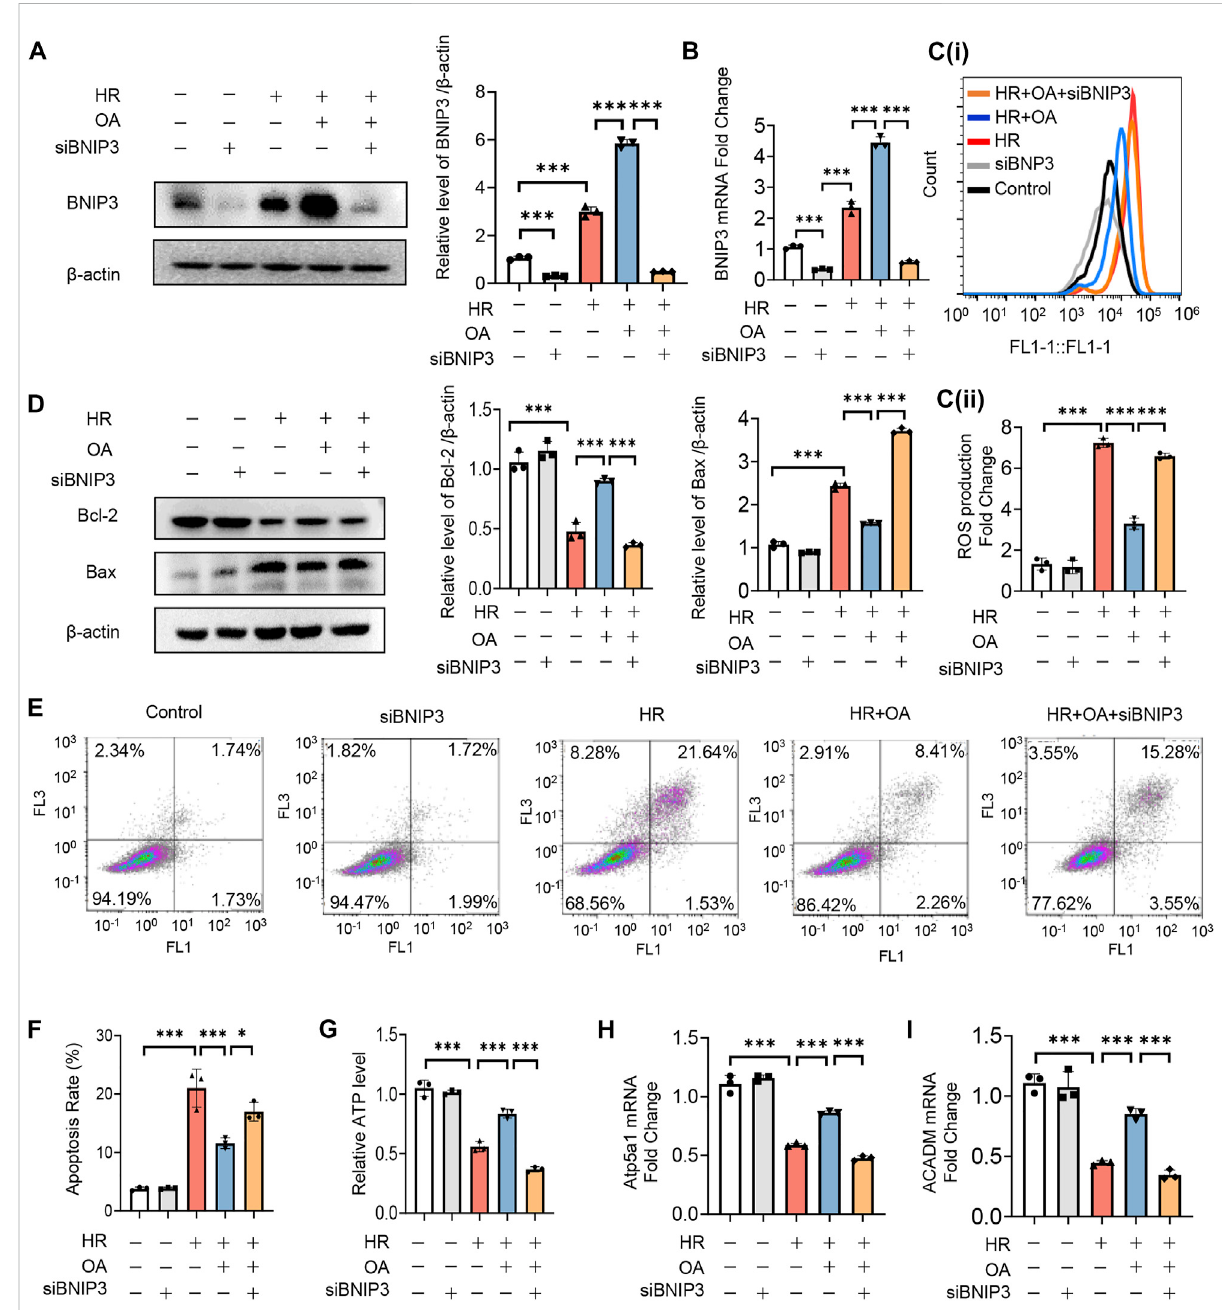
FIGURE 4 OA improves mitochondrial homeostasis imbalance through inducing BNIP3 expression. (A – I) After 24 h transfection with siBNIP3, HK-2 cells were exposed to HR and treated with control or OA. The protein expression level of BNIP3 (A) , the levels of BNIP3 mRNA (B) , ROS (C) , apoptosis (D – F) ,ATP (G) ,theexpressionlevelsofOXPHO-relatedgene (H) andFAO-relatedgene (I) weredetected( n =3).Dataareexpressedasmeans±SEM. p P < 0.05, ppp P <